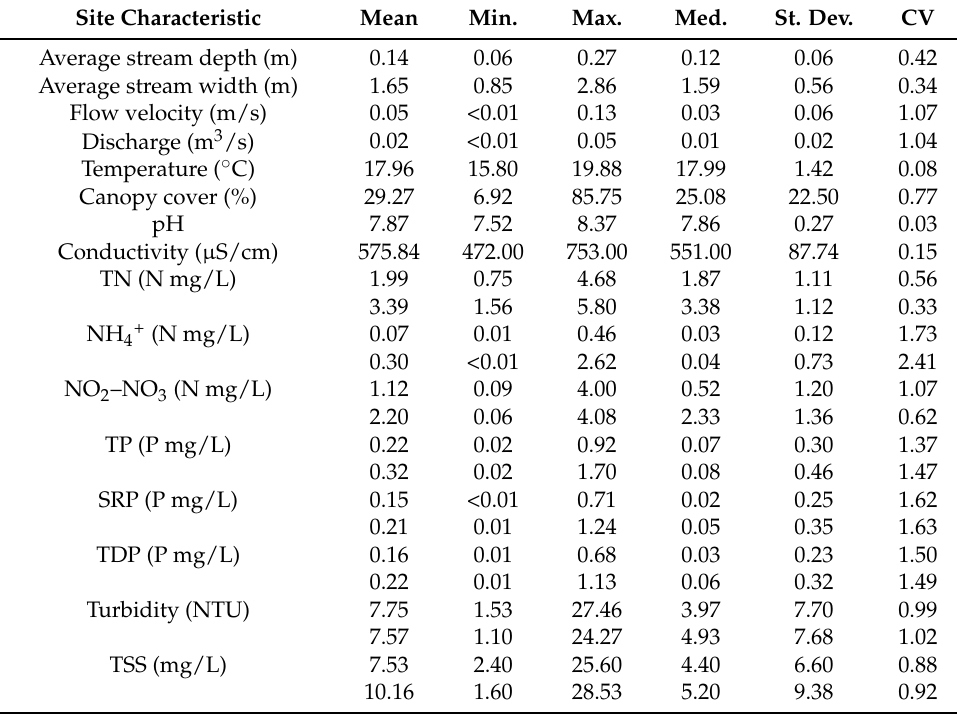
Table 3. Descriptive statistics for physico-chemical parameters collected from 13 study streams. Water quality parameters were measured during logger deployment (shaded rows) and after the sampling period during logger retrieval (unshaded rows). Values of <0.01 indicate concentrations or velocities below detection